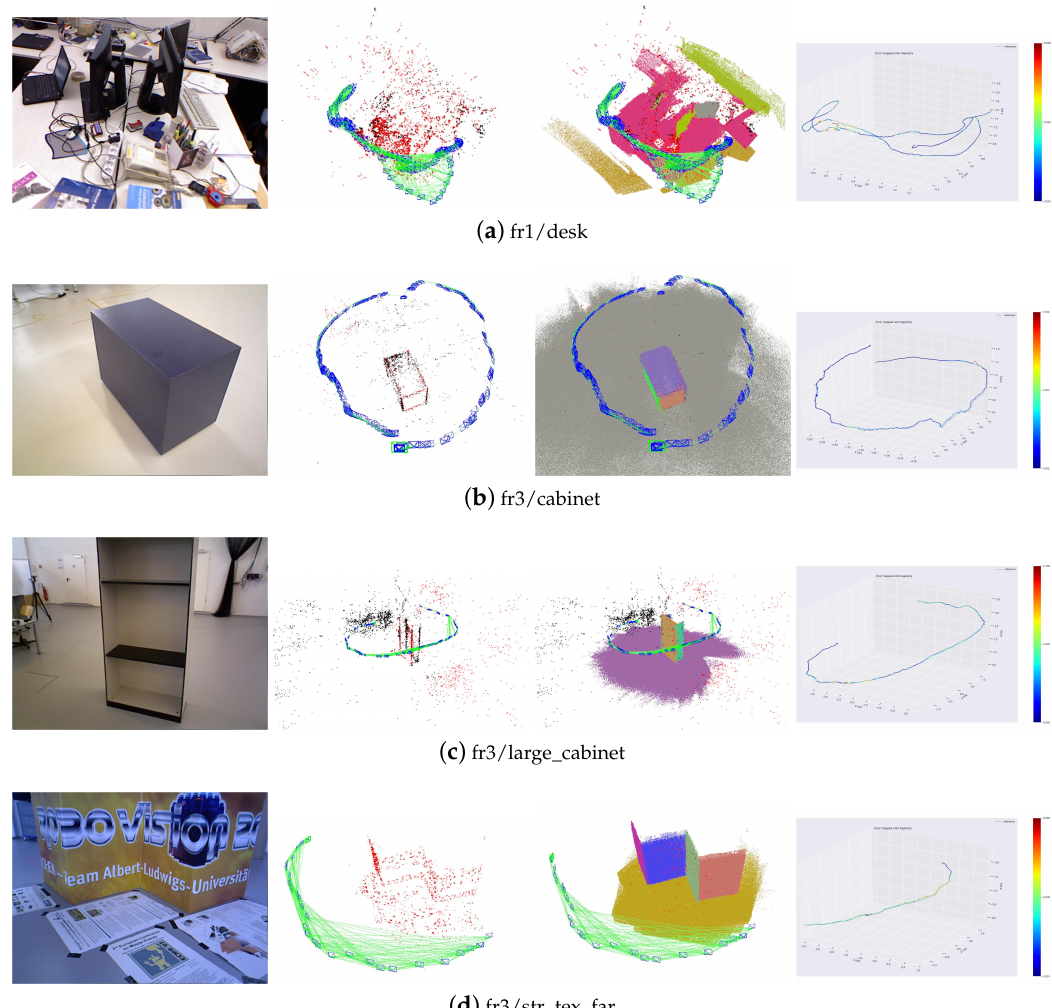
Figure 12. Trajectories and reconstruction results. The first column is the image showing the scene. The second column shows the point landmarks. The third column shows the plane and point landmarks together. The fourth column is the comparison of the estimated trajectories and corresponding ground